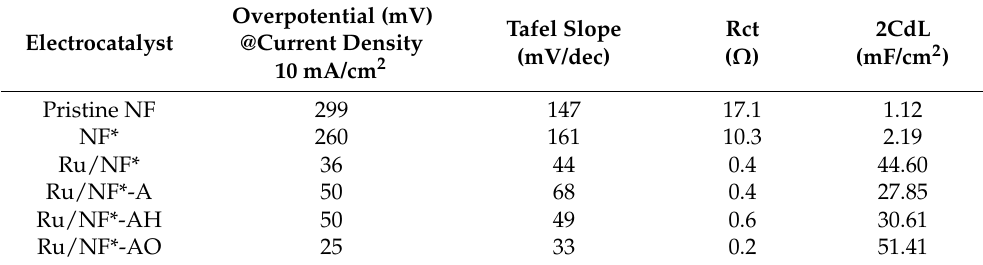
Table 2. Corresponding parameters of electrocatalyst in 1M KOH as calculated from Figure 5.